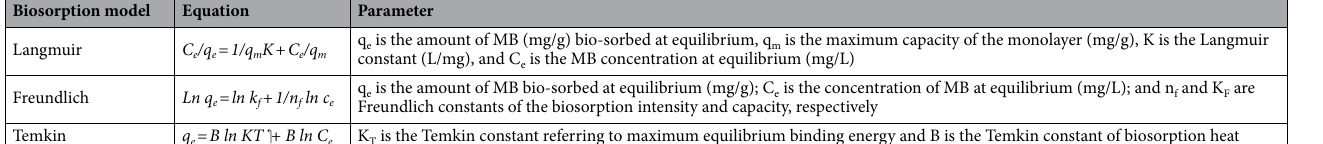
Biosorption model